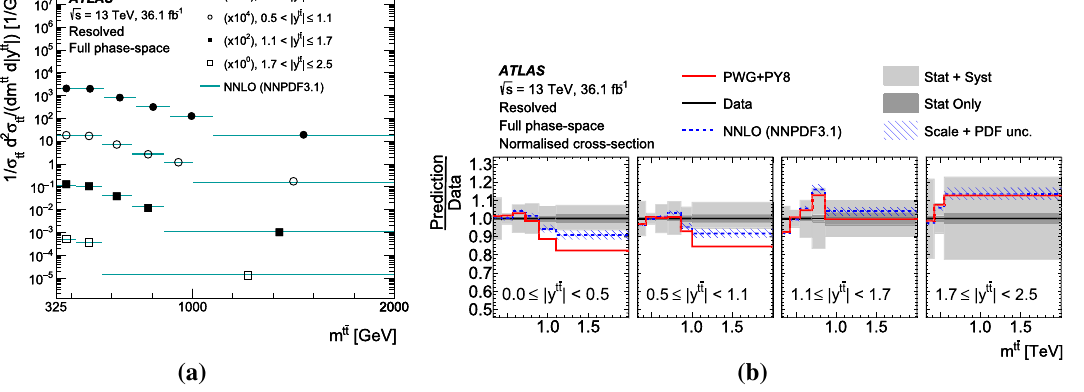
Fig. 63 a Parton-level normalised differential cross-section as a func- (cid:7) (cid:7) (cid:7) in the resolved topology compared with the (cid:7) y t ¯ t tion of m t ¯ t in bins of NNLO prediction obtained using the NNPDF3.1 NNLO PDF set. Data points are placed at the centre of each bin. b The ratio of the measured